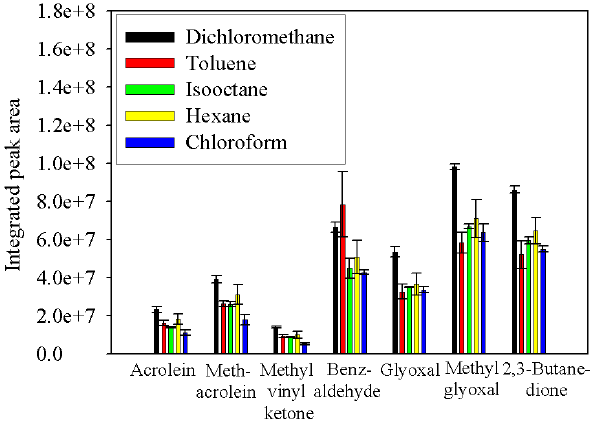
Figure 1. Influence of the extraction solvent dichloromethane (black), toluene (red), isooctane (green), hexane (yellow) and chlo- roform (blue) on the integrated peak areas of the standard com- pounds acrolein, methacrolein, methyl vinyl ketone, benzaldehyde, glyoxal, methyl glyoxal and